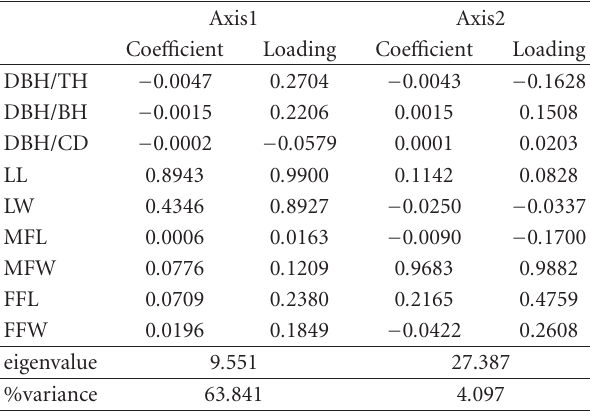
Table 2: Results from principal component analysis (PCA) of morphometric traits. Axis1 Axis2